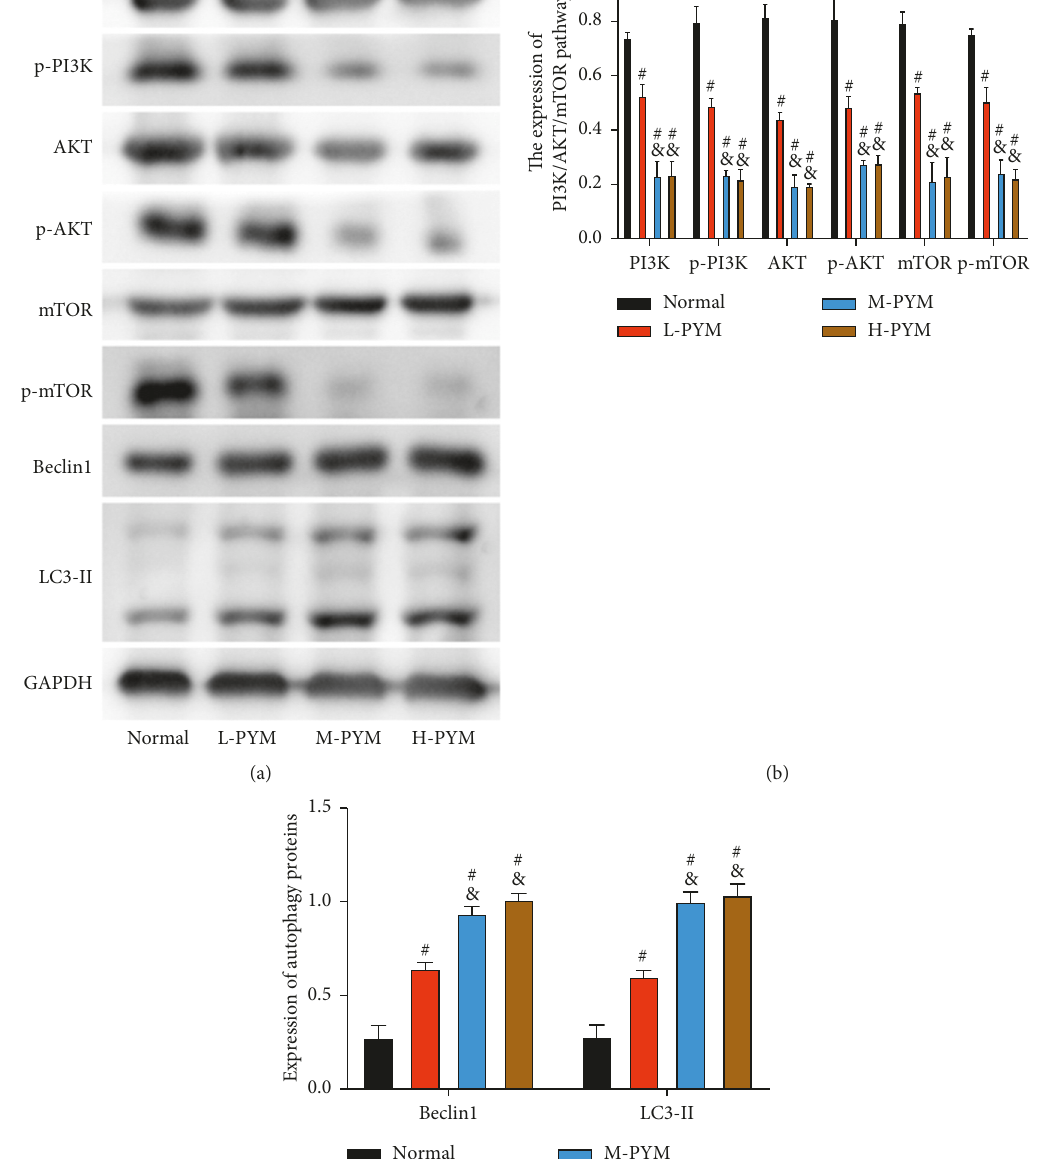
0 . 05. Compared with the L-PTM group, & P <